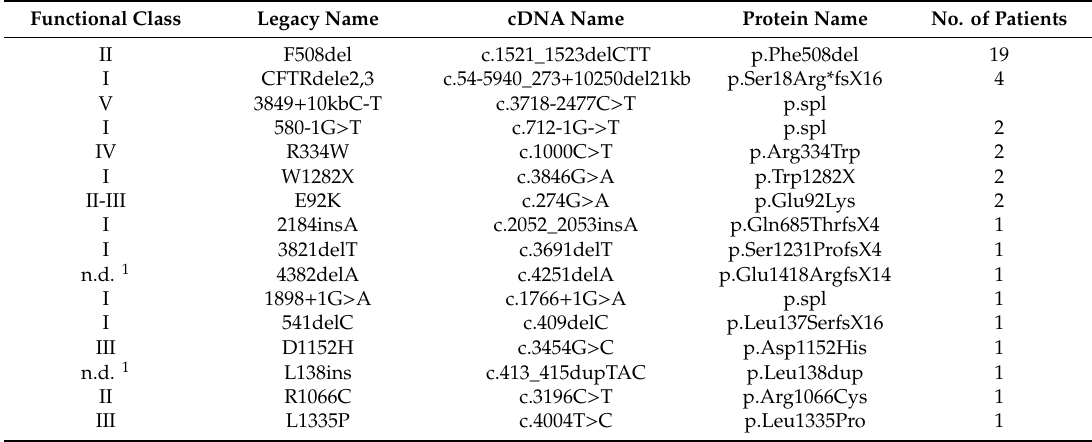
Table 1. The second alleles of CF patients carrying the c.3844T > C (p.Trp1282Arg, W1282R) variant in trans